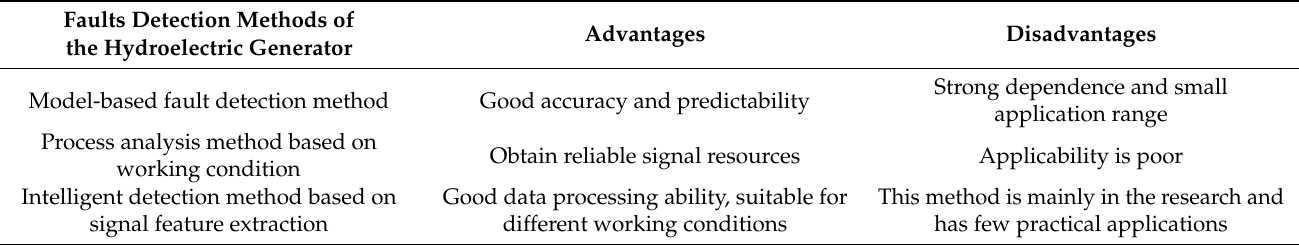
Table 1. Faults detection methods of the hydroelectric